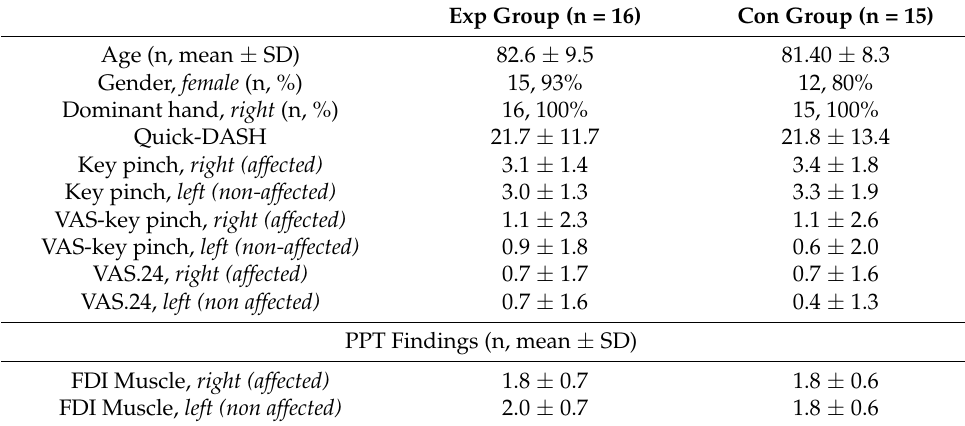
Table 1. Baseline demographics for both groups *.